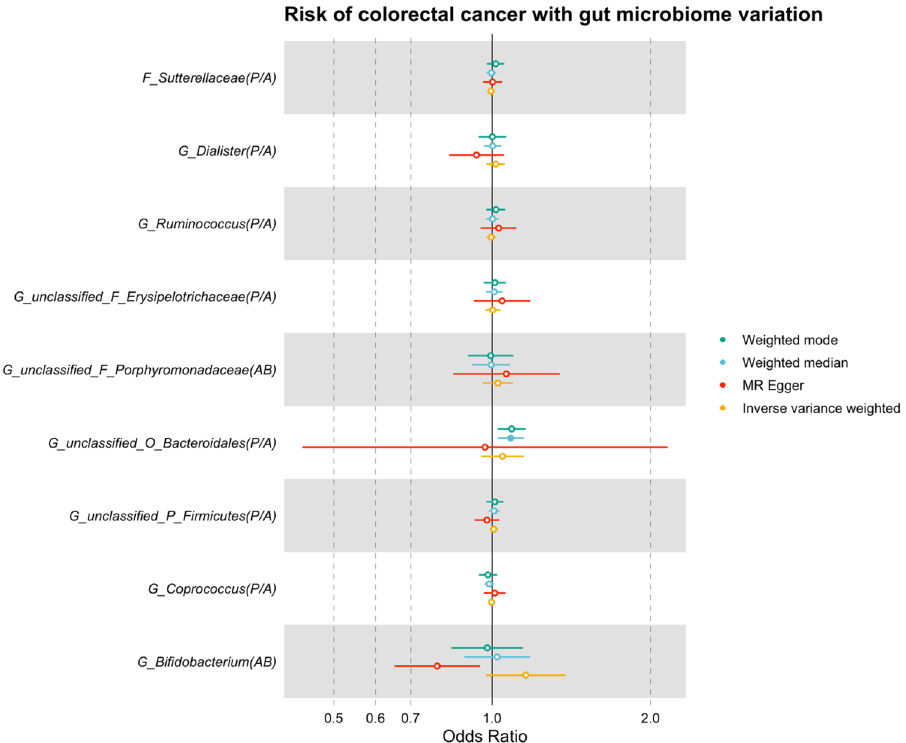
Figure 4. MR estimates of the effect of each microbial trait on overall CRC risk using a more lenient p -value threshold for selecting genetic instruments. AB = abundance; CI = confidence interval; CRC = colorectal cancer; mGWAS = microbiome genome-wide association study; MR = Mendelian randomization; OR = odds ratio; P/A = presence versus absence; SD = standard deviation. Letters in the microbial trait name represent the taxon classification level from which that microbial trait was observed, with "C", "F", "G", "O" and "P" representing "class", "family", "genus", "order" and "phylum", respectively. All microbial traits that were not confidently classified at the genus level were organised into unclassified groups within higher classification levels (represented by "unclassified"). MR estimates represent the OR for CRC risk and 95% CI per SD unit change for AB microbial traits or per approximate doubling of the genetic liability to P / A of each binary microbial trait. Results for the inverse variance weighted, weighted median, weighted mode and MR-Egger methods) are presented when using the multi-SNP instrument for each microbial trait using a lenient p-value threshold ( P < 1 × 10 −05 ) and directional consistency across cohorts included in the mGWAS and were compared to the Wald ratio estimates obtained from the main